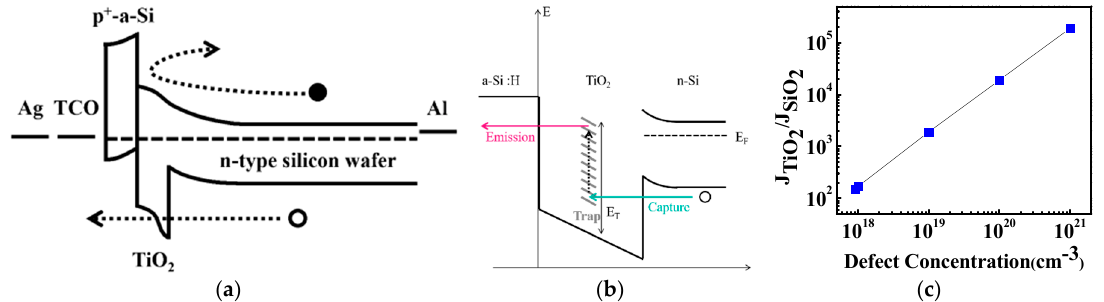
Figure 3. ( a ) Band alignment of proposed TiO 2 /Si heterojunction solar cell; ( b ) enlarged part of band diagram at E V around interface of TiO 2 /Si; and ( c ) ratio of tunneling current through TiO 2 to that through SiO 2 ( J TiO2 / J SiO2 ) according to gap state concentration.